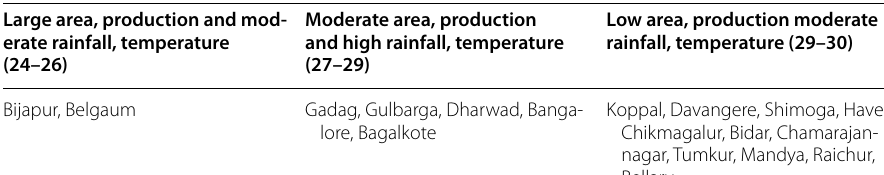
Table 2 Results CLARA algorithm